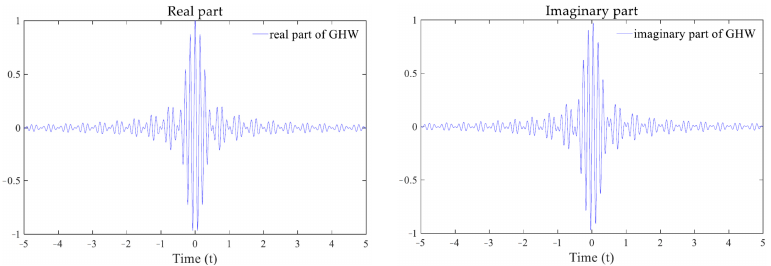
Figure 2. Real and imaginary parts of GHW at n = 8, m = 6, Δ = 2, k = 0.